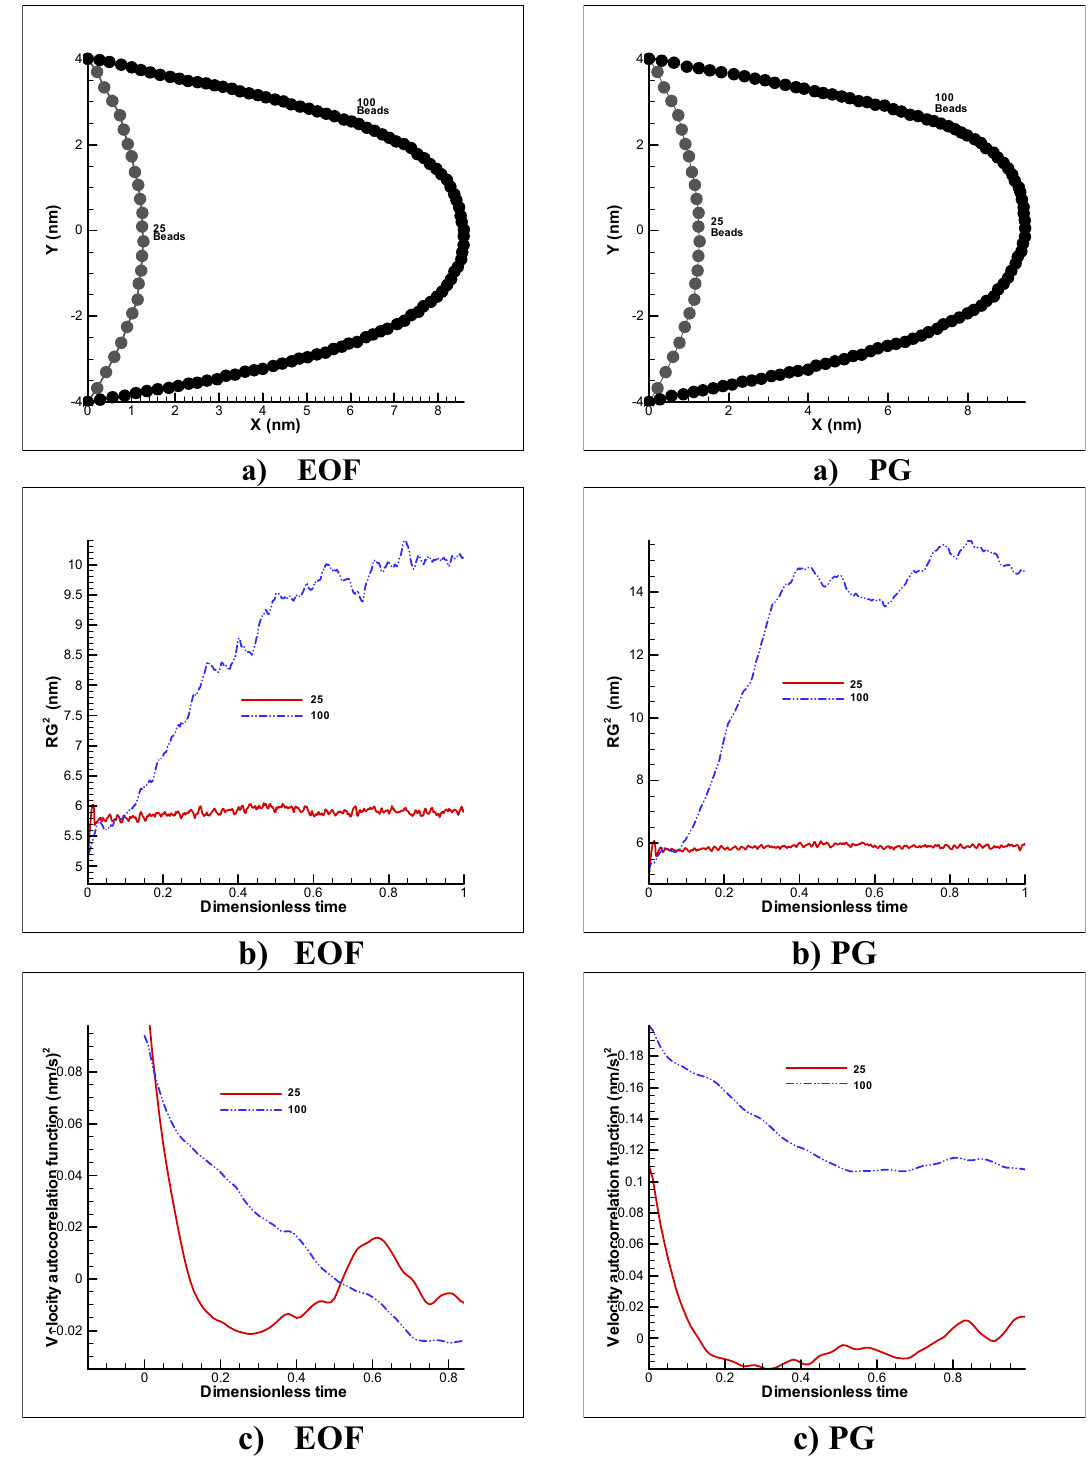
Figure 11. Movement with fixed two ends of a polymer chain in a simple channel (a), changes in gyration radius ( b ) and velocity correlation function ( c ) over time considering different n = 25 and n = 100 beads for both pressure gradient and electroosmotic flow test